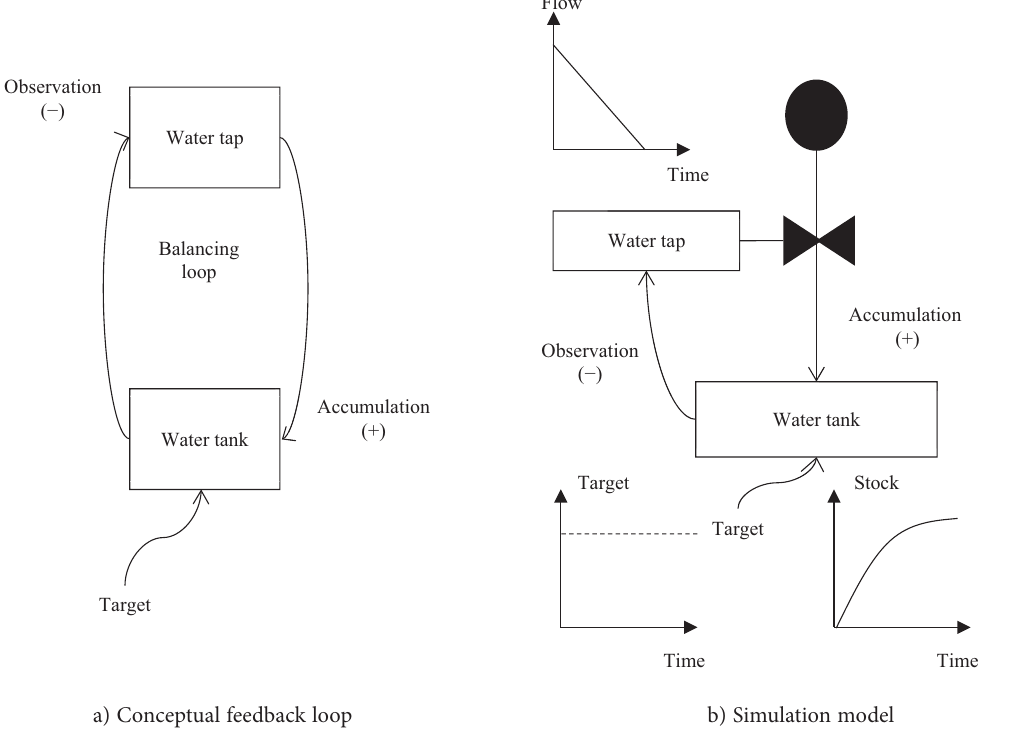
Figure 1. System